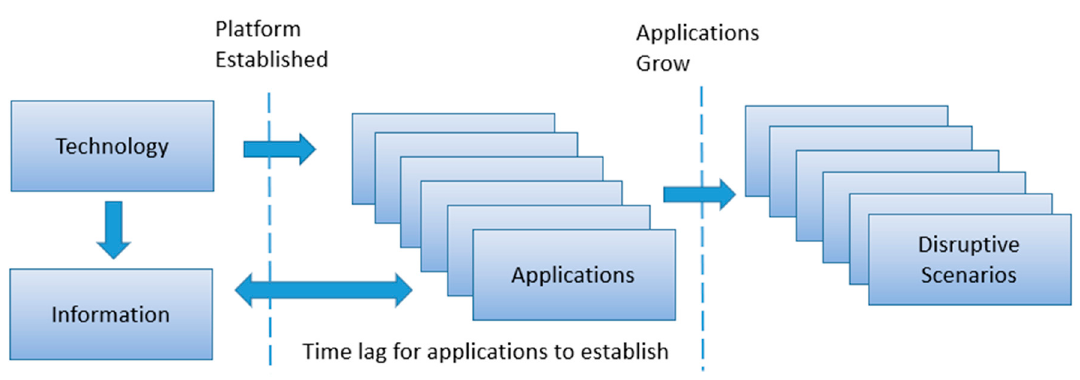
Figure 8. Platform evolution cycle.